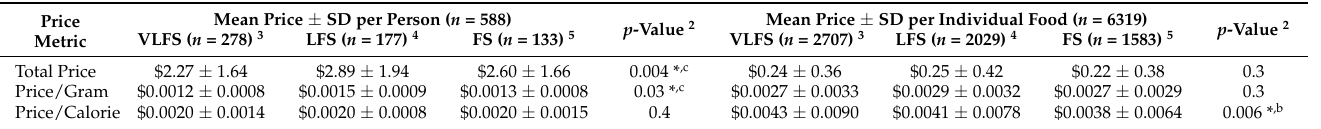
Table 2. Mean price metrics for total reported 24-h dietary intake among adults using rural, Midwest- ern food pantries recruited in 2014 1 .